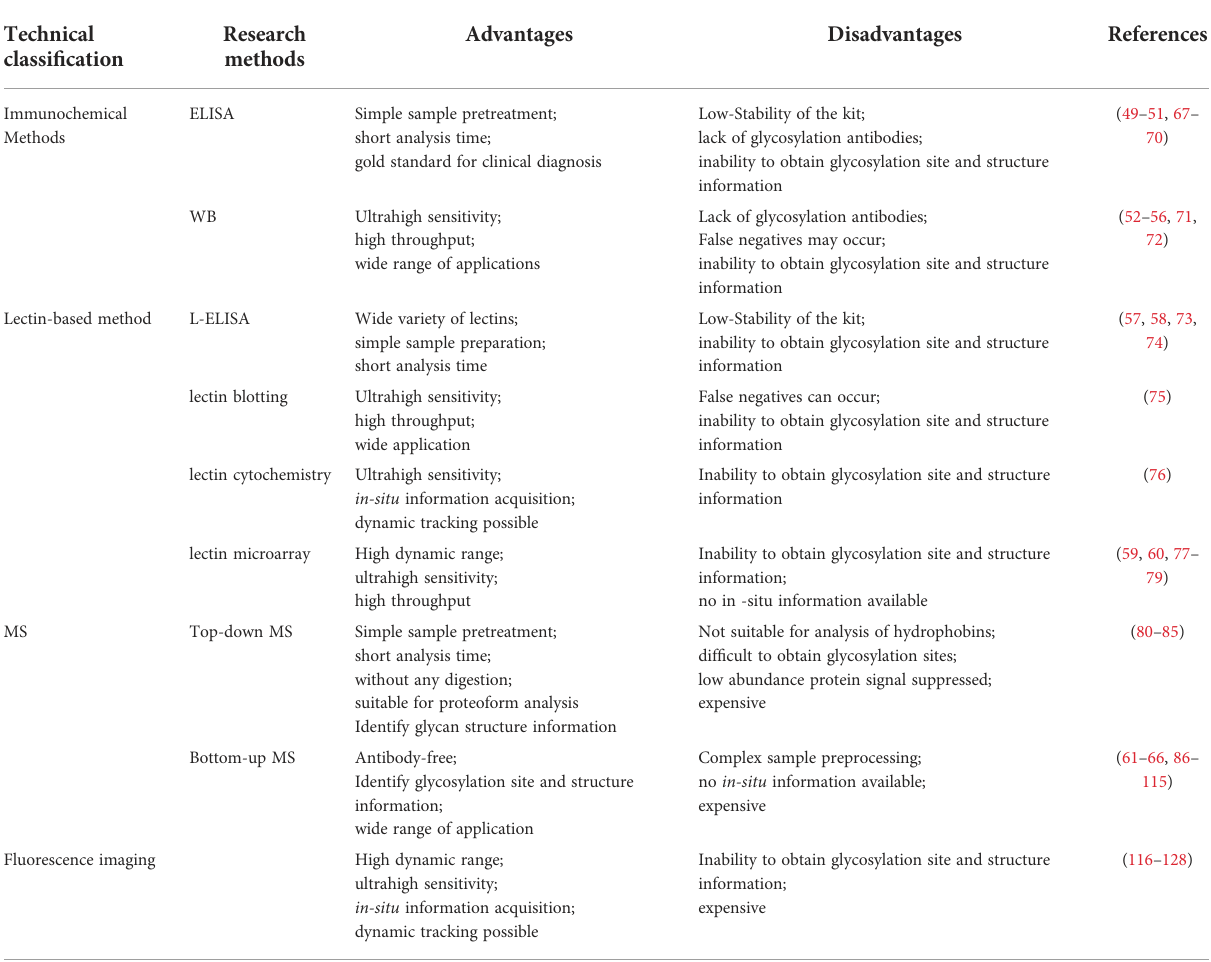
TABLE 2 Advantages and disadvantages of representative glycosylation analysis